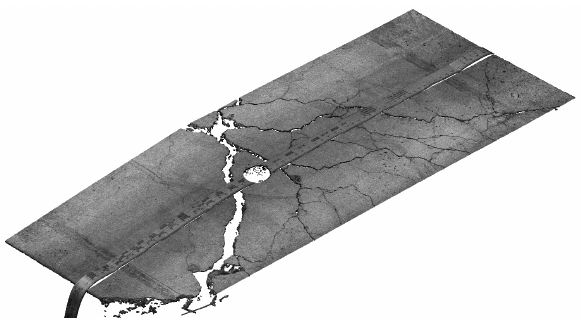
Figure 8. 2D-intensity map of plate using PPS-Plus.